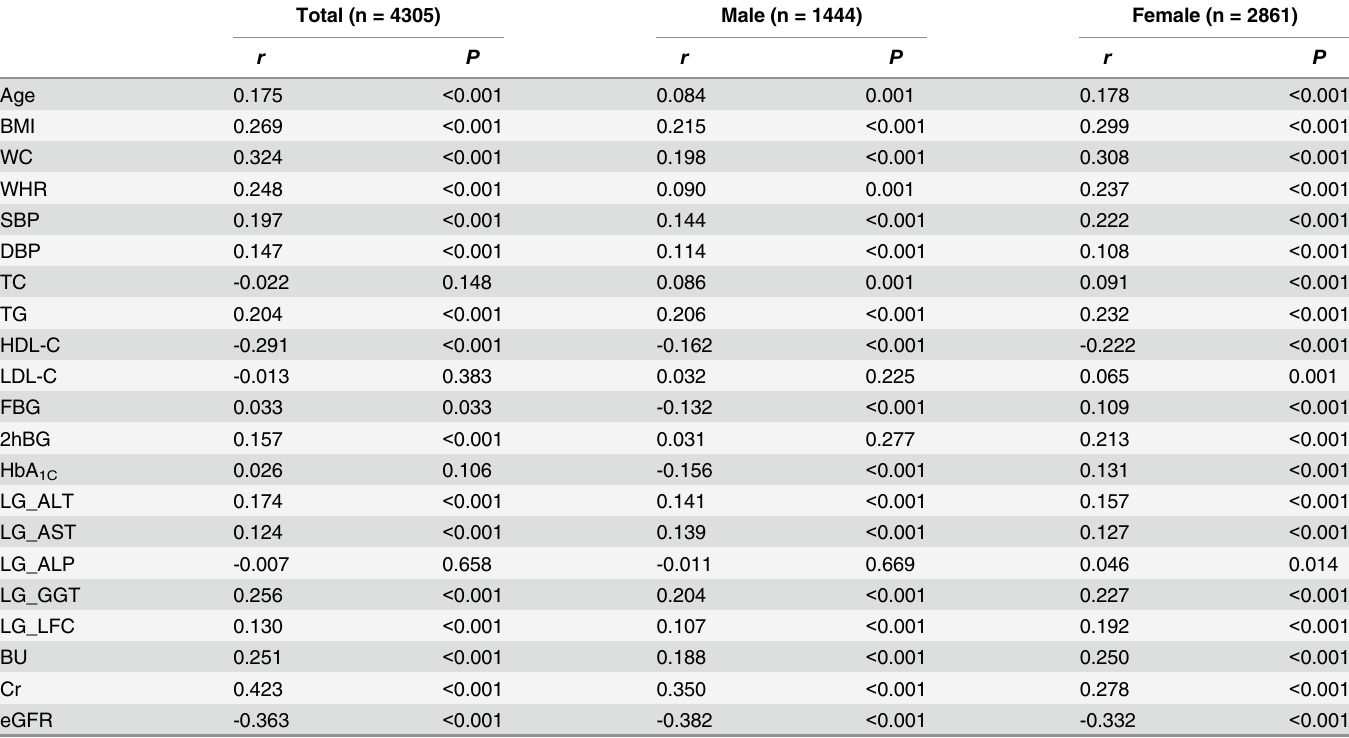
Table 2. Correlation coefficients between serum uric acid and all related clinical parameters, including